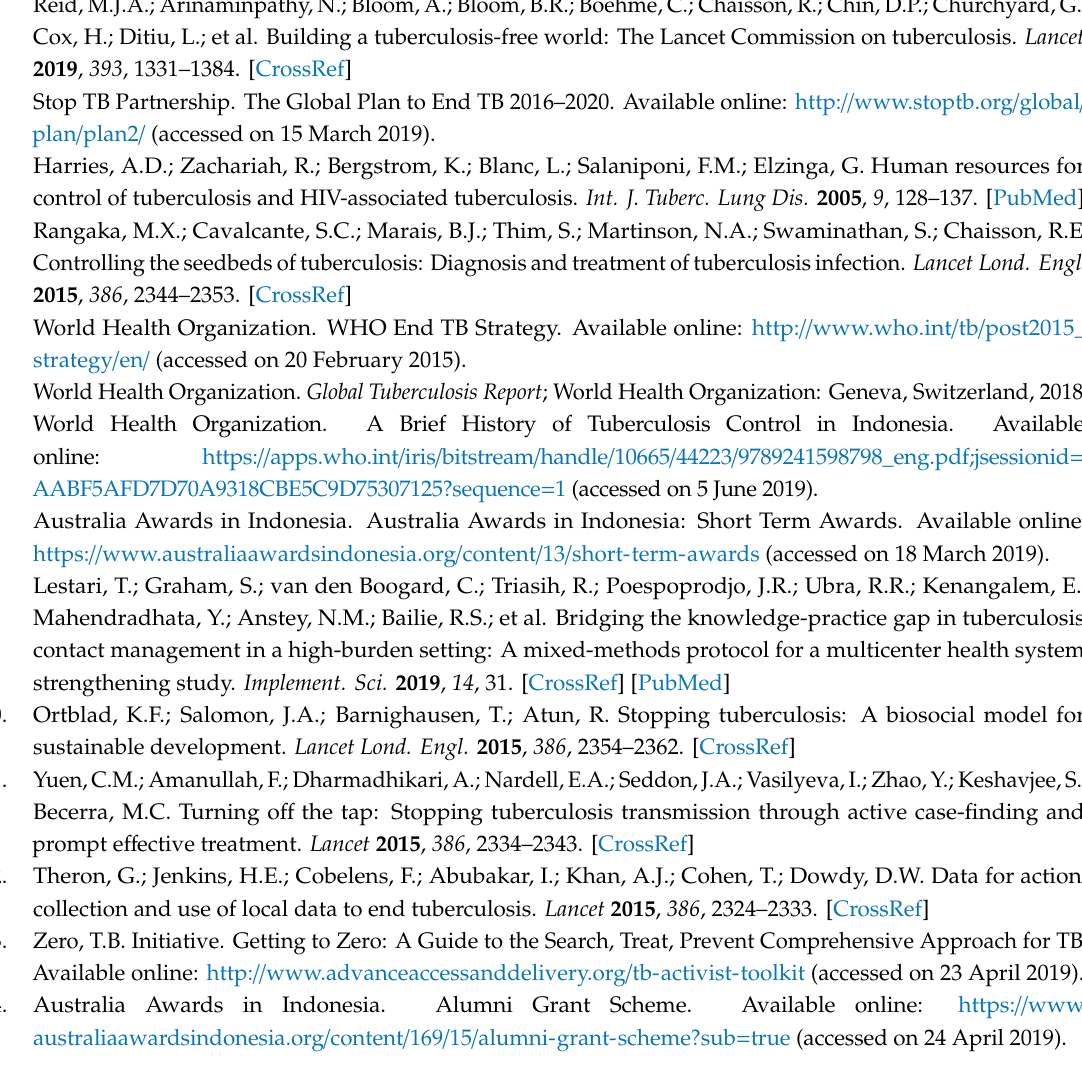
Table S1: Participant Self-Evaluation of Learning Growth. Table S2: TB Elimination Post Training Survey. Table S3; Overview of projects developed by course